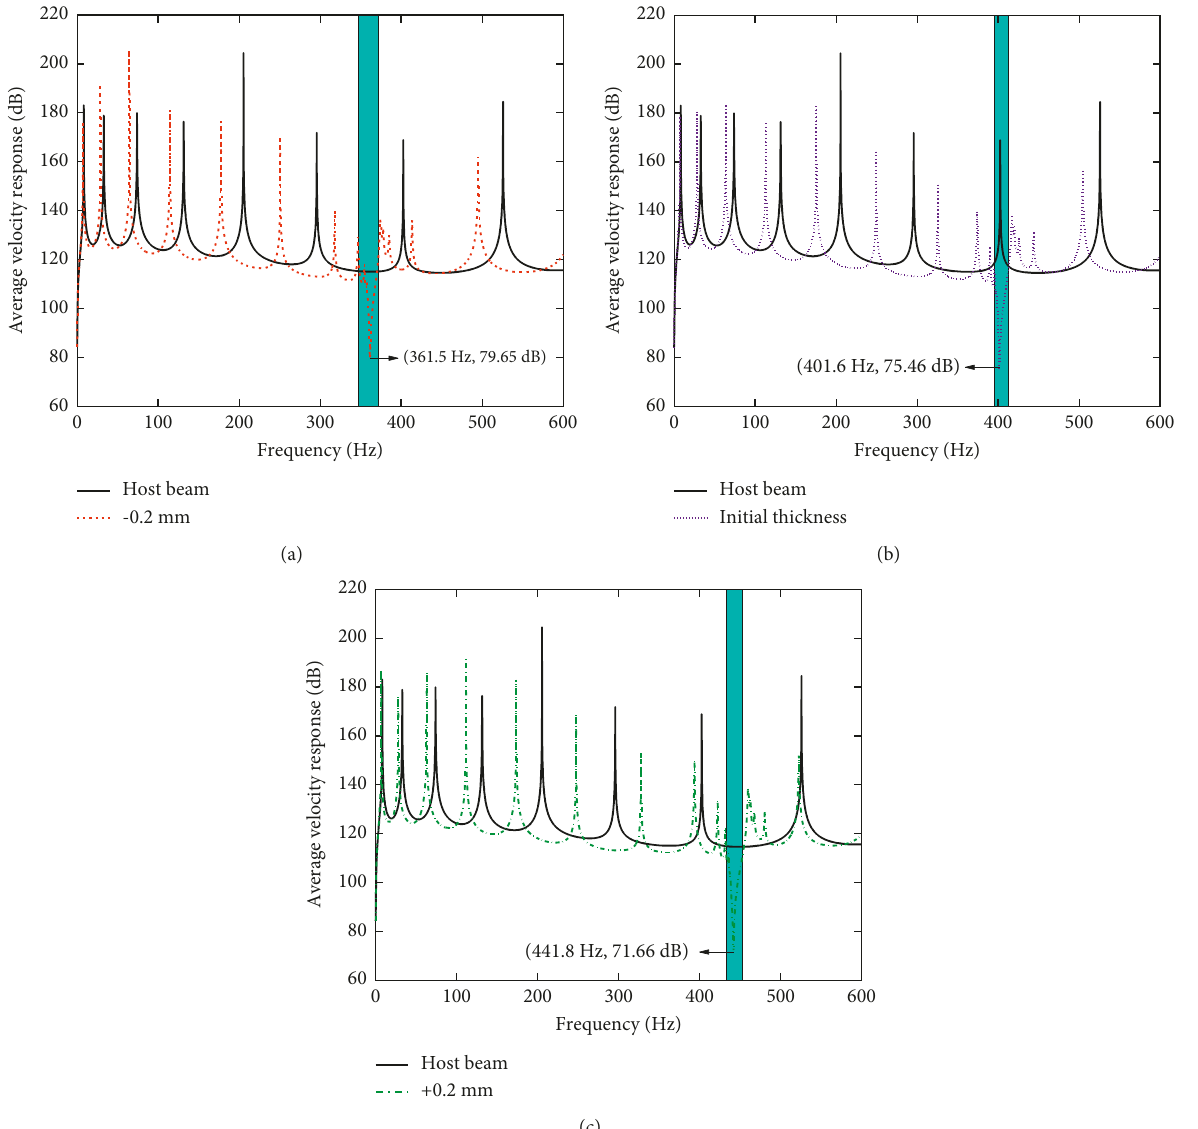
Figure 9: Influence of the beam-like resonator’s thickness on the vibration properties of the locally resonant